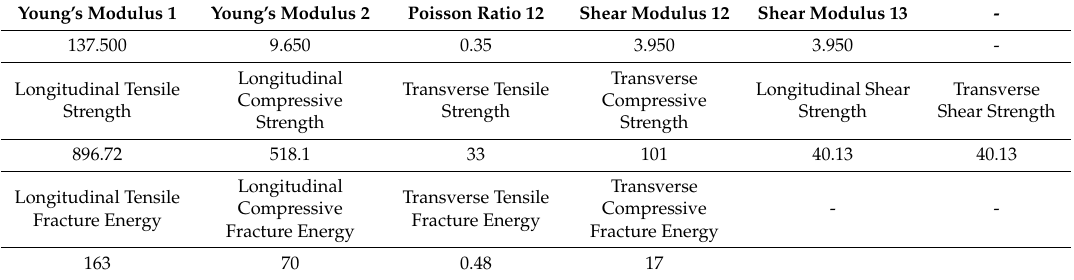
Table 1. Laminates’ and repair patches’ mechanical and fracture properties (MPa and J / m 2